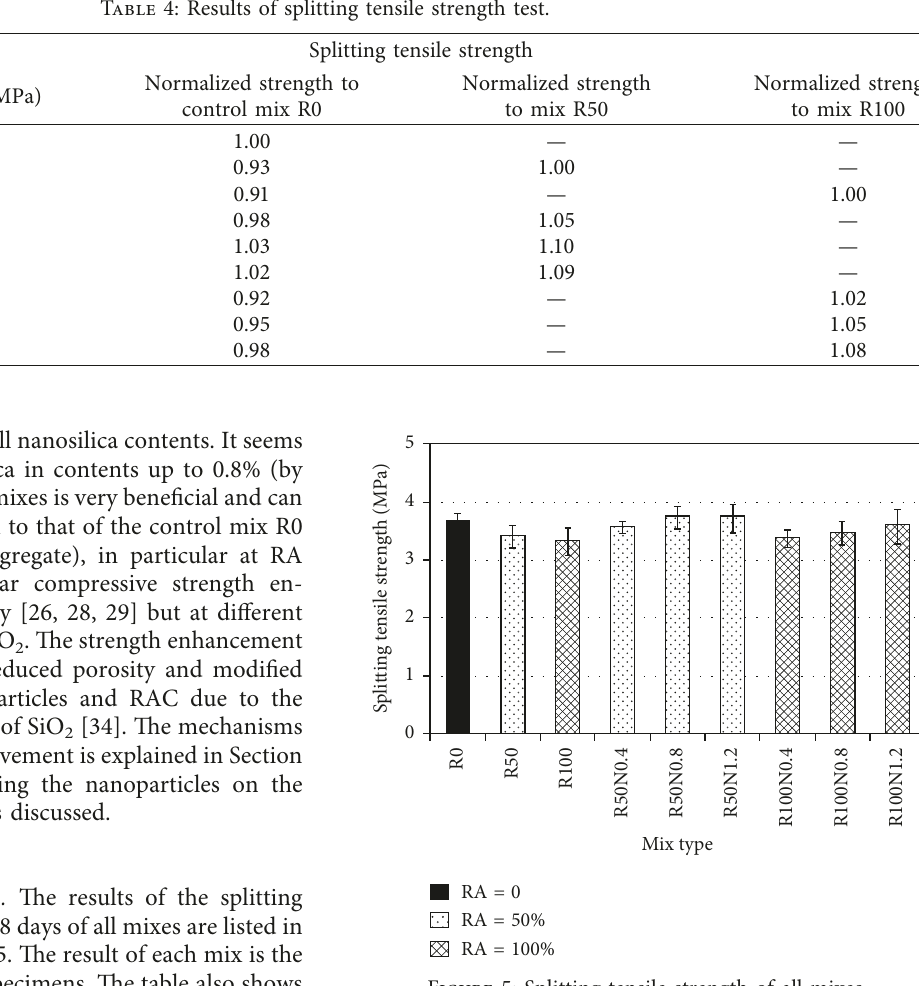
Figure 5: Splitting tensile strength of all mixes.